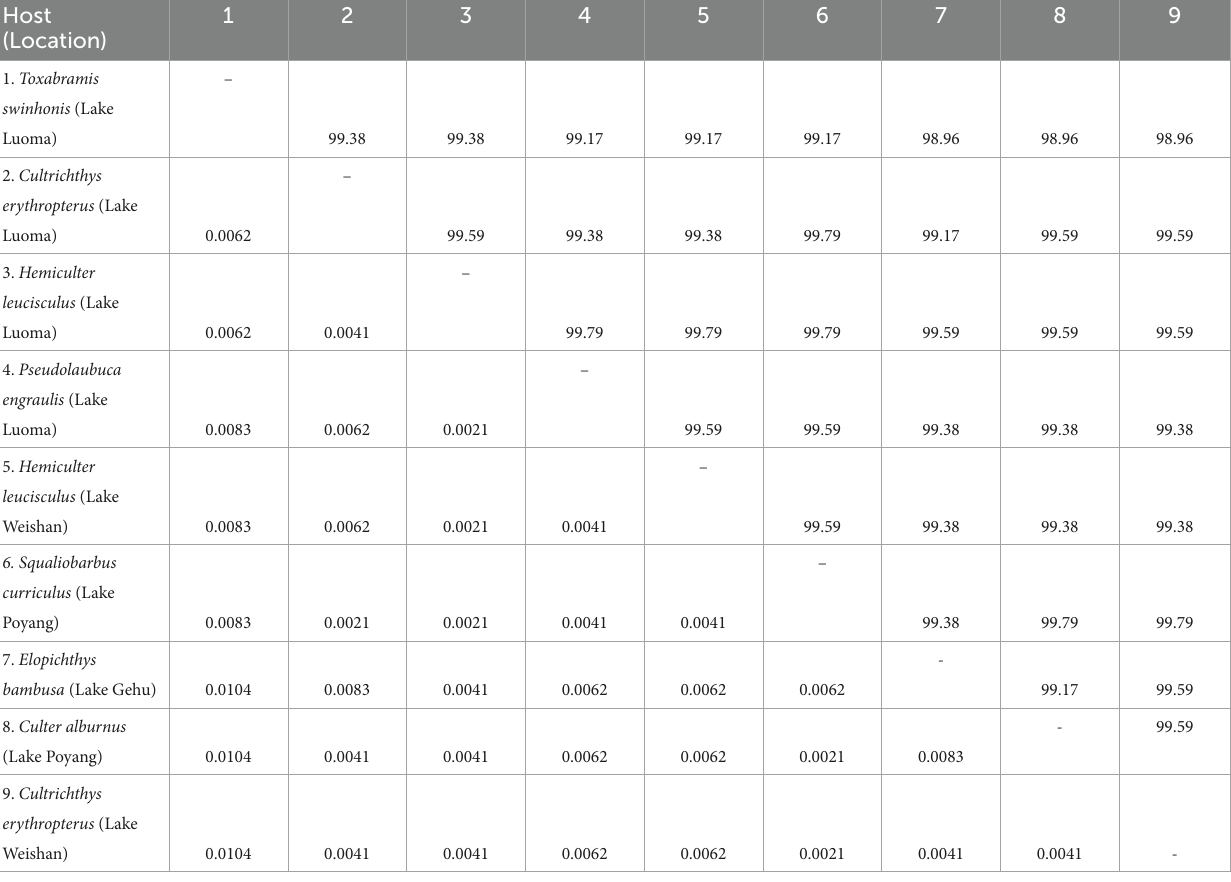
TABLE 5 Pairwise nucleotide sequence identity (upper right) values and evolutionary distances (left bottom) among P. alburnus isolates isolated from different hosts and locations by Kimura-2 Parameter analysis based on LSU rDNA sequences. Host (Location)